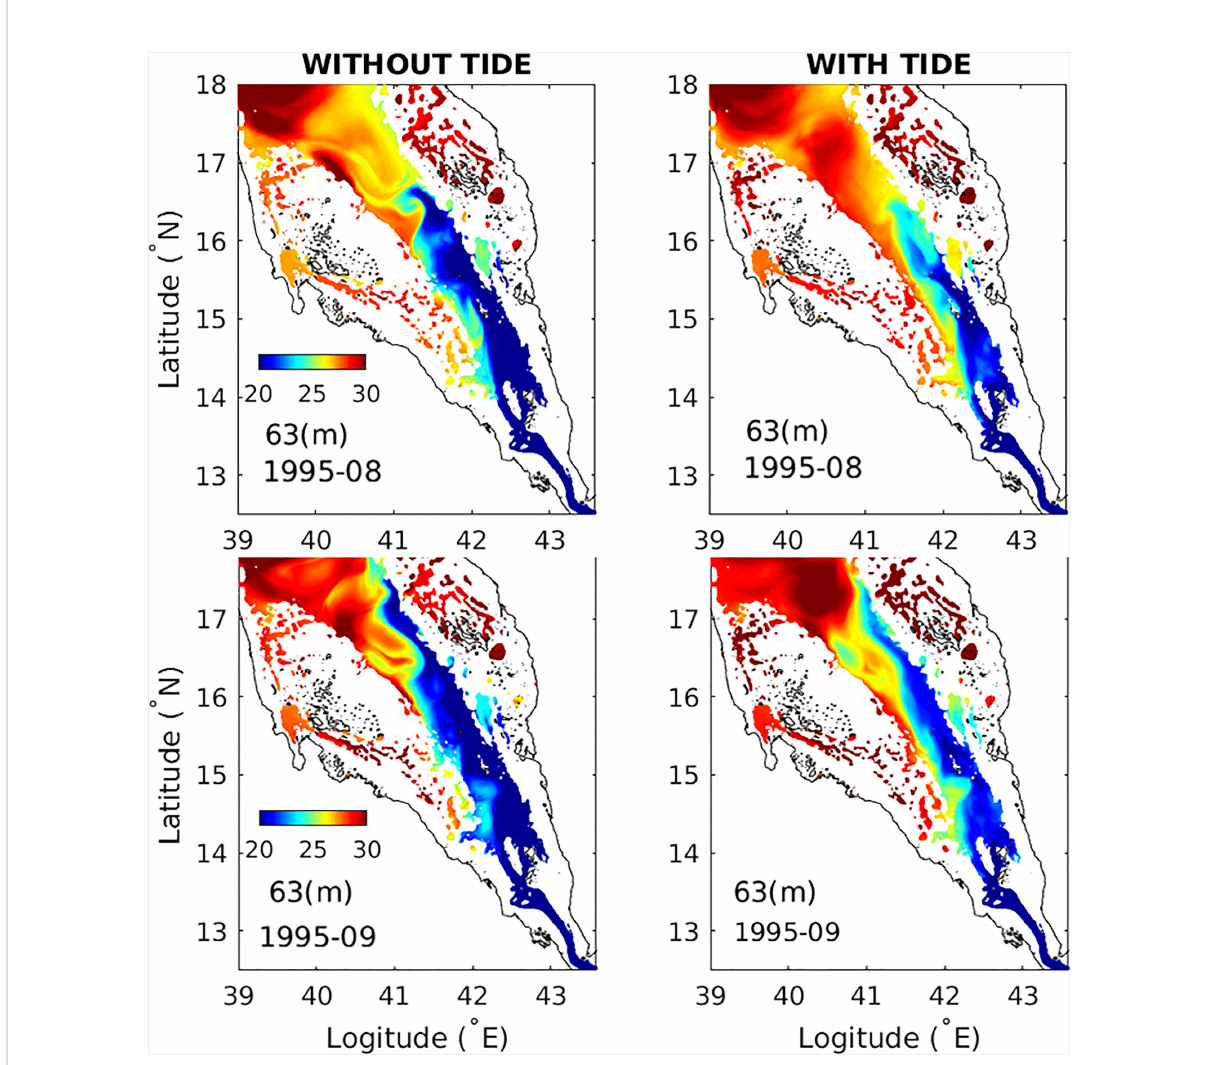
FIGURE 4 A comparison of the horizontal extension of the summer intrusion of GAIW at mid-depth (63 m) between the runs without tides (left panels) and with tides (right panels). The time variations of the monthly-mean potential temperature are shown for August and September in the upper panels and lower panels,